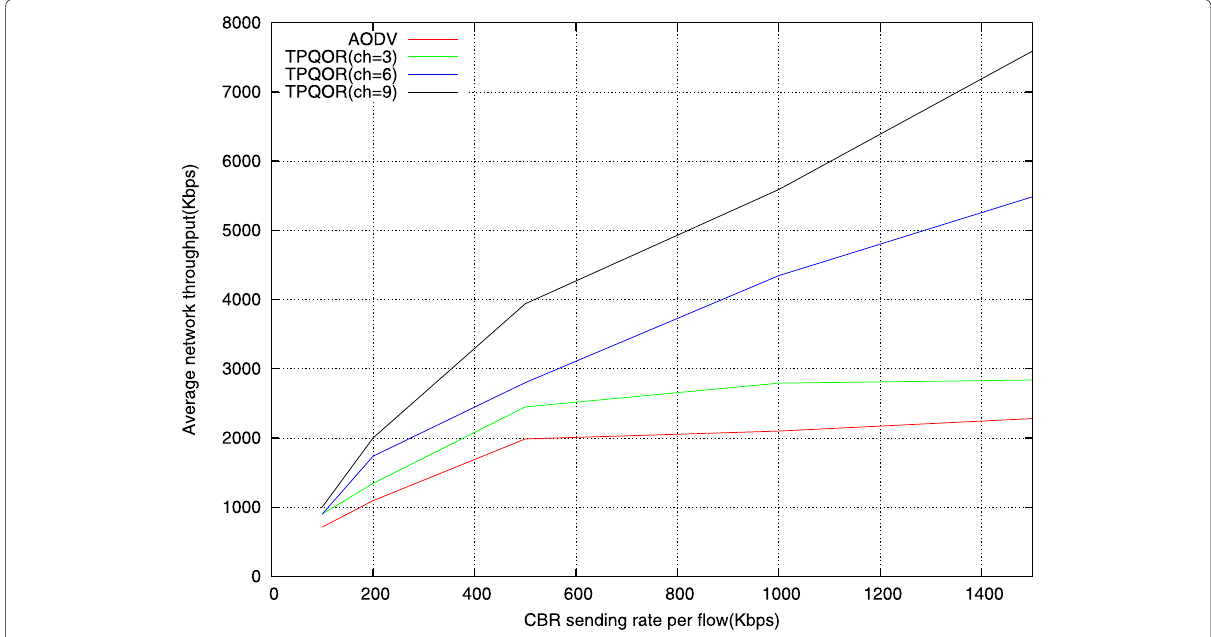
Fig. 6 Average network throughput at different loads